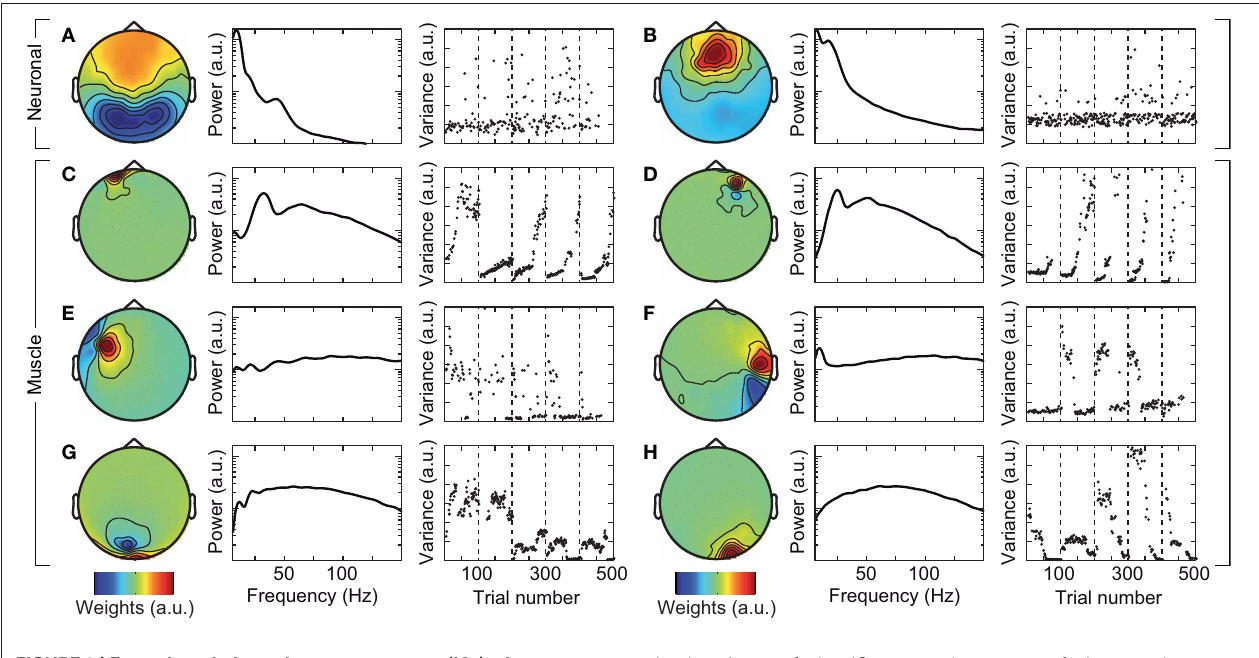
signal variance of the IC across the course of the experiment. Examples in left and right columns are taken from different